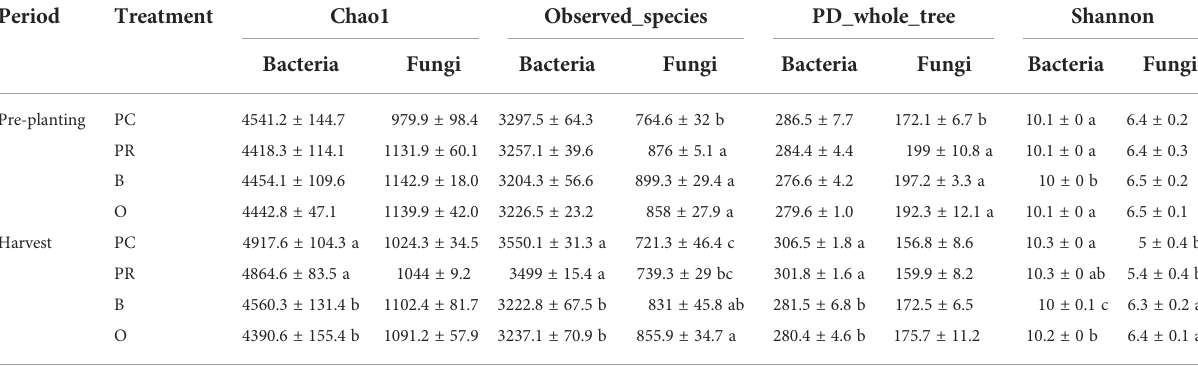
Lowercase letters within a column mean signi fi cant differences among treatments (p < 0.05). Data represent mean values ± SE (n = 3).